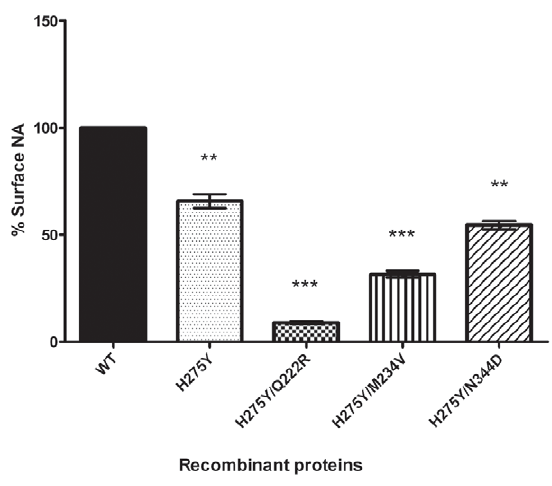
Figure 2. Surface activity of recombinant A/Brisbane/59/2007- like (H1N1) neuraminidase proteins. 293T cells were transfected with pCAGGS-PA, -PB1, -PB2, and -NP plasmids in addition to plasmids expressing the WT or mutant A/Brisbane/59/2007-like neuraminidases (NA) proteins. At 24 h post-transfection, cells were treated with a non- lysing buffer and surface NA activity was measured by using the fluorogenic substrate (MUNANA). Percent surface NA activities were determined in triplicate experiments 6 standard deviations. ** P , 0.01 and *** P , 0.001 compared to the WT surface NA activity.